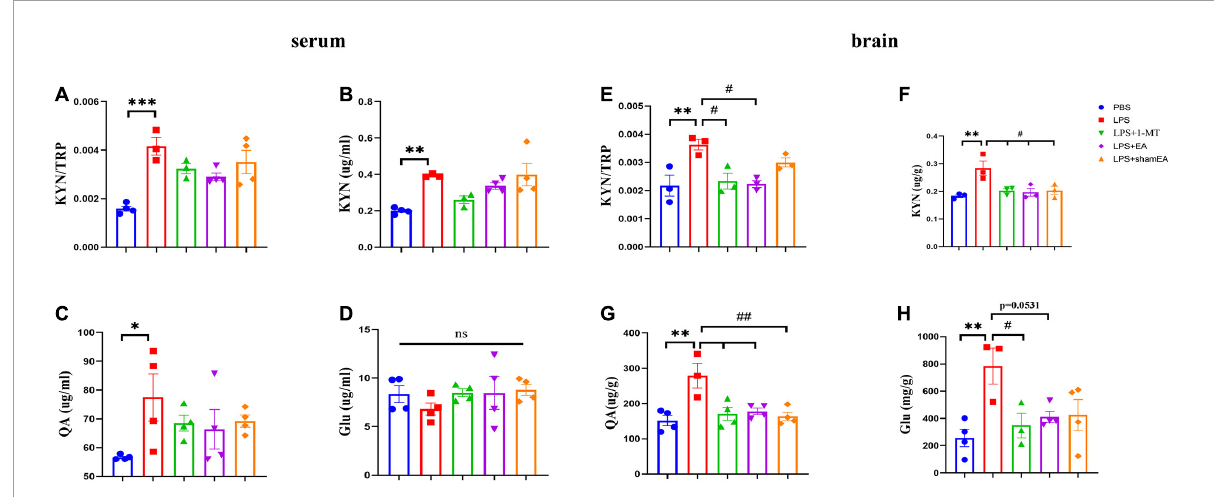
FIGURE5 Electroacupuncture regulates concentration levels of TRP: KYN, KYN, QA, and Glu. After behavior tests, the tissue and serum of mice were collected and analyzed for the metabolism level of KYN (B,F) , QA (C,G) , and QA (D,H) , and the ratio of KYN to TRP (A,E) . The results are expressed as the mean ± SEM. * p < 0.05, ** p < 0.01, *** p < 0.001, compared with the saline group; # p < 0.05, ## p < 0.01, compared with the LPS group; ns , no statistical